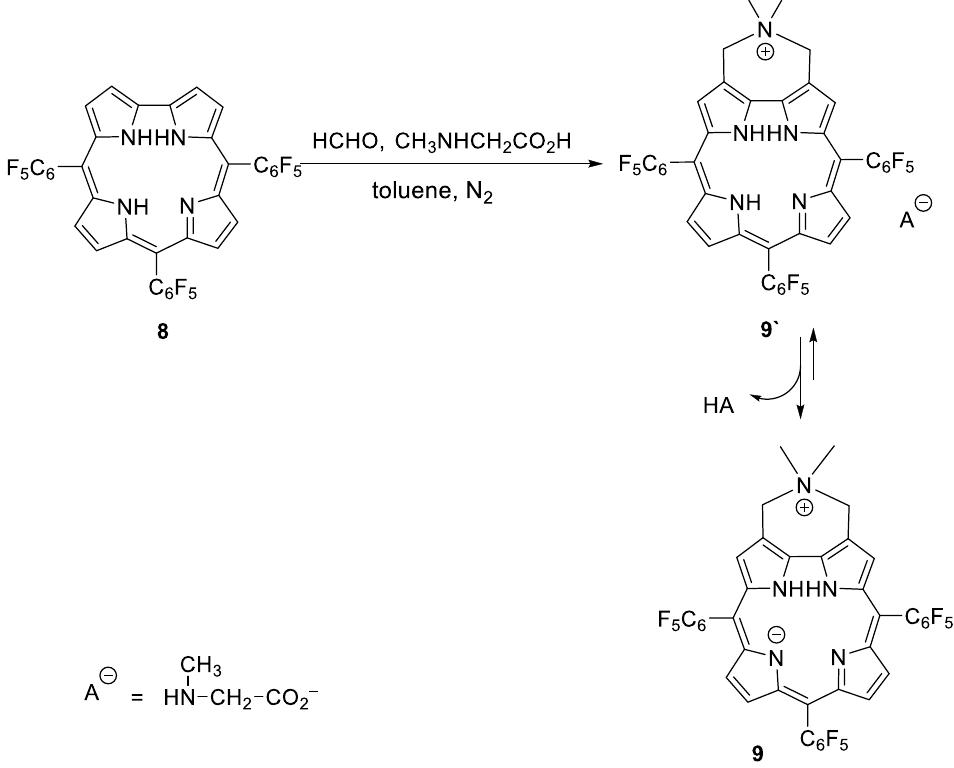
Scheme 4. Reaction of 5,10,15-tris(pentafluorophenyl)corrole with sarcosine and paraformalde- hyde.